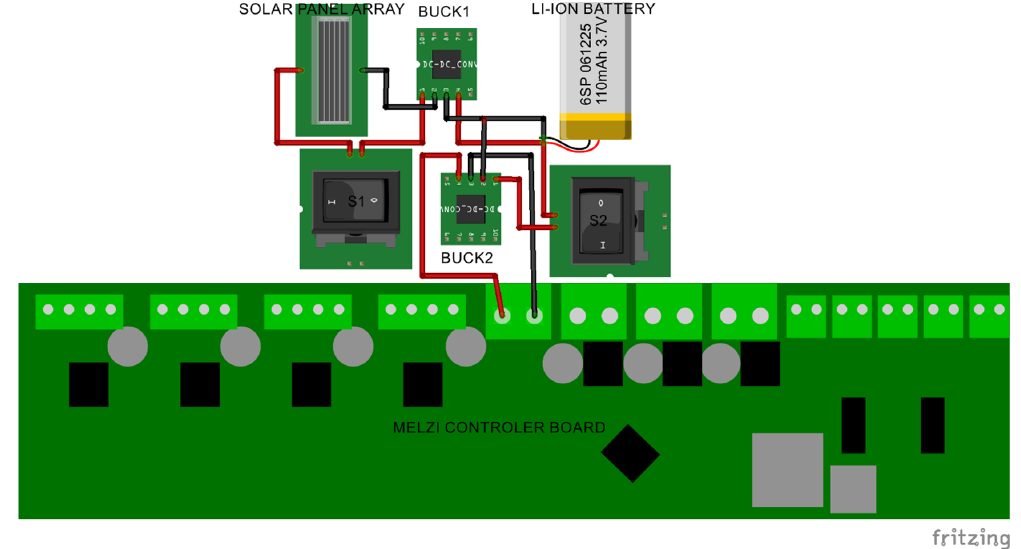
Figure 3. Wiring diagram of the power circuit.